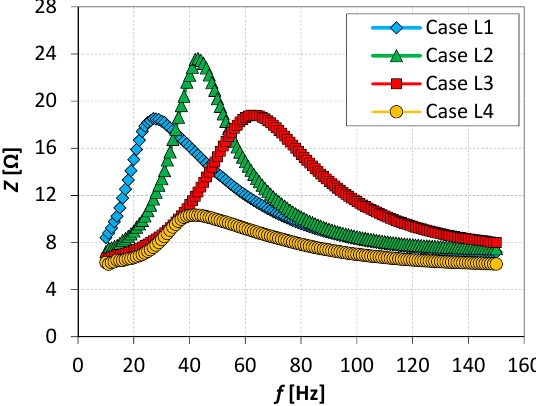
Figure 4. SJA impedance as a function of frequency, P = 4.0 W.